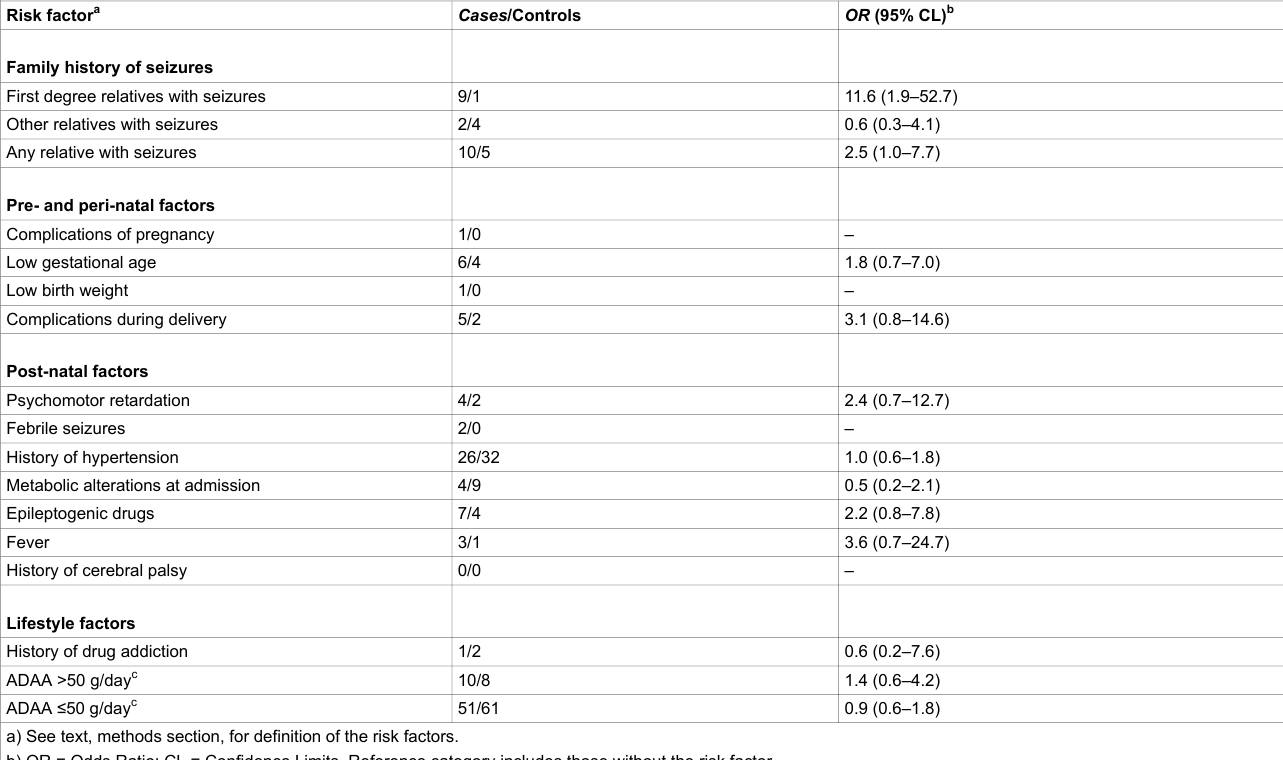
Table 1: Risk factors for a first seizure symptomatic of brain tumour or brain vascular malformation (102 cases and 121 controls). Risk factor